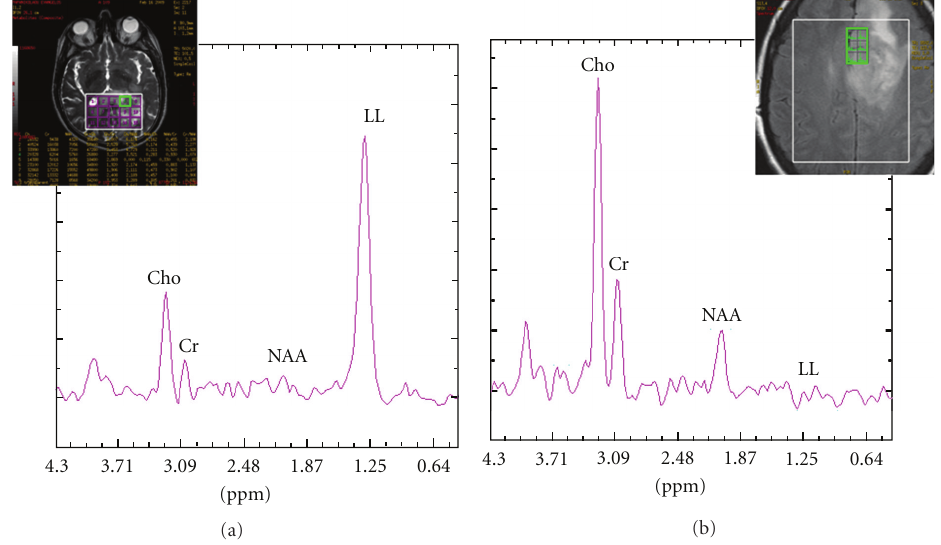
Figure 4: Long TE 1 H-MRSI spectra of a 54-year-old male (a) and a 47-year-old female (b) with glioblastoma multiform and anaplastic oligoastrocytoma, respectively. Spectra illustrate high grade glioma intratumoral patterns of (a) high LL peak and (b) absence of LL peak